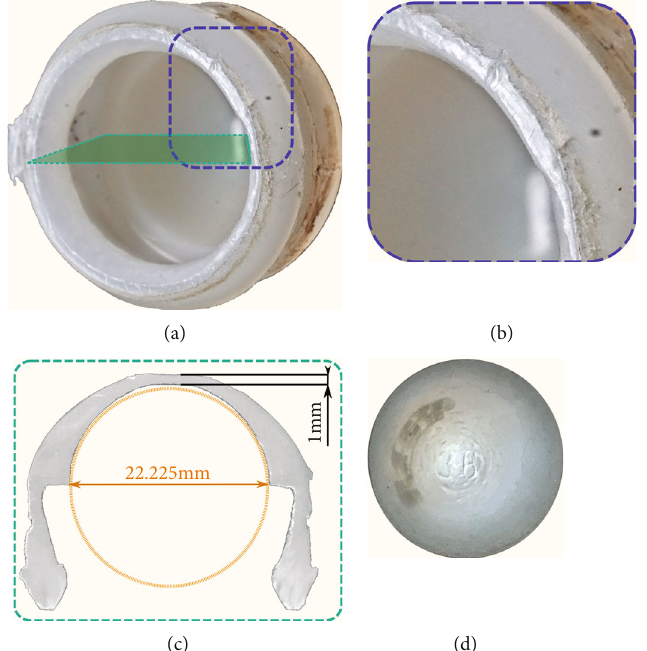
Figure 6: Disassembled PE liner of the bipolar head (a) with signs of stem impingement around the opening (b); a 22.225mm (nominal diameter) sphere fi tted into the cross section in the supposed unworn position (c); imprinting of the bipolar head metal surface on the bottom, indicating cold fl ow of the PE